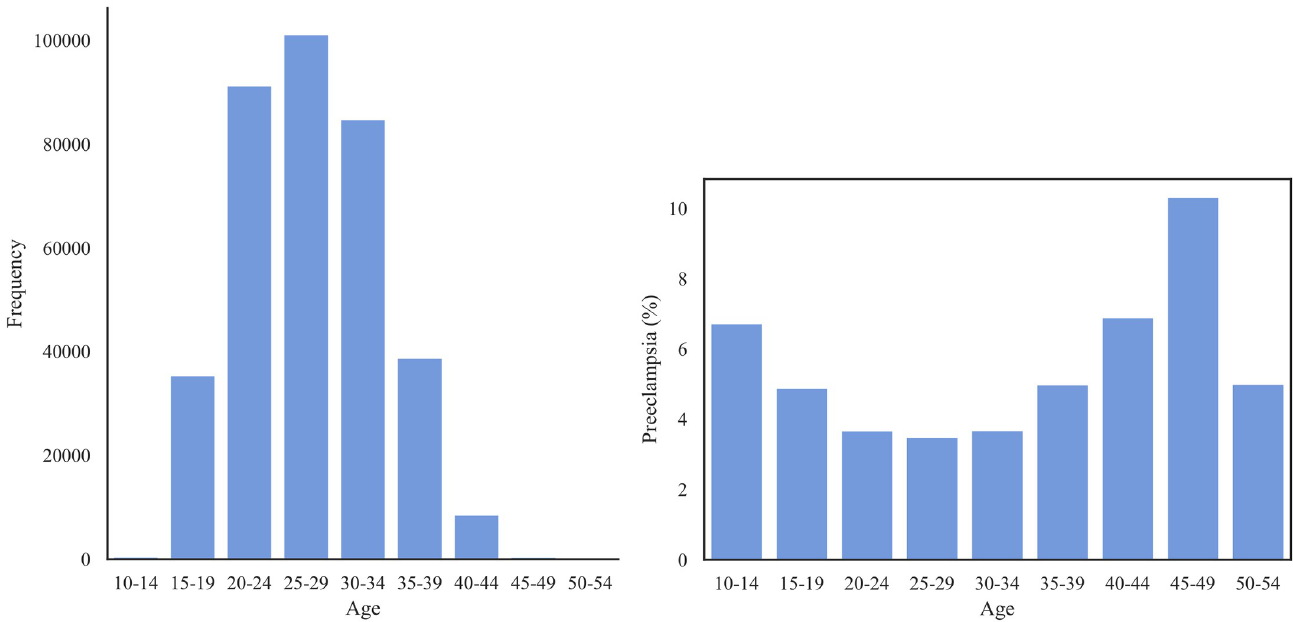
Fig 2. Left: The distribution of age group in Texas PUDF; Right: The prevalence of PE (%) for each age group.